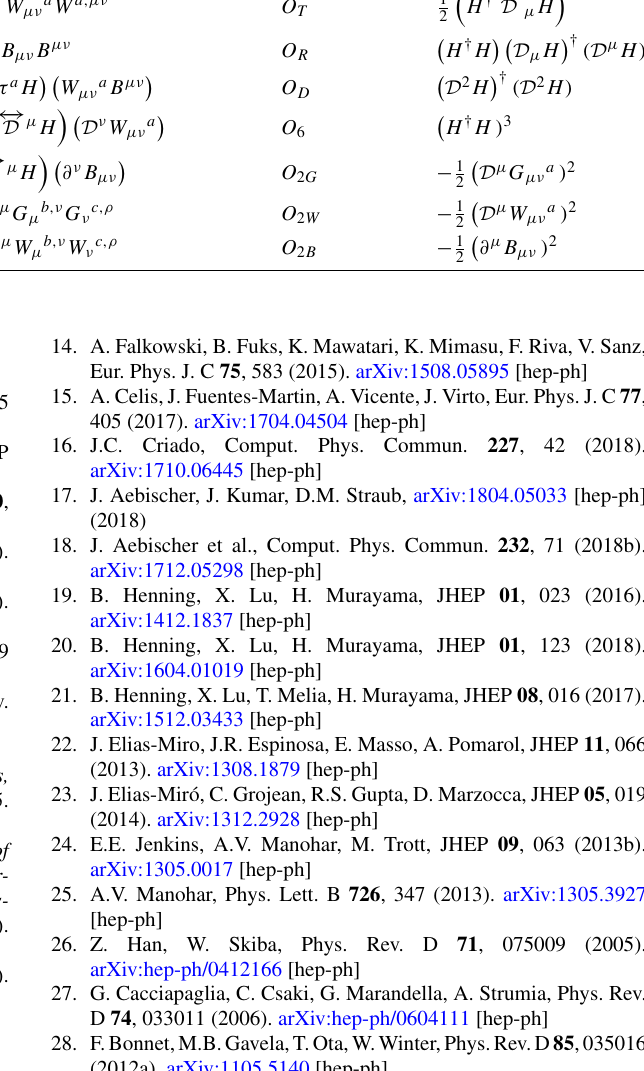
operators in “SILH”